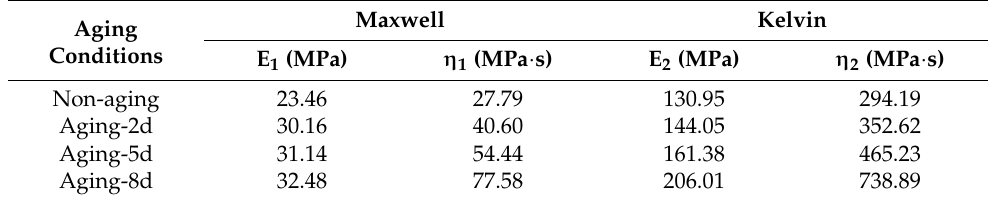
Table 2. Burgers model parameters of the asphalt mastic with different aging conditions.